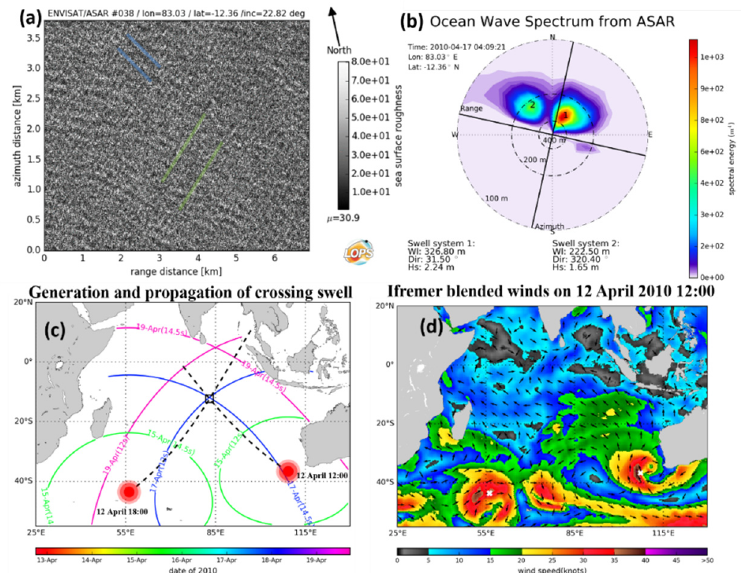
Figure 2. Example of crossing swell in Region A from refocused ASAR observation. ( a ) Roughness of ASAR imagette and ( b ) its corresponding Level-2 swell spectrum (17 April 2008). ( c ) Map illustrating the generation and propagation of this event, with dashed and colored lines indicating swell propagating routes, and the predicted arrival times from the swell origins, respectively. ( d ) Ifremer blended winds (12 April 2008 12:00). Red disks and white crosses indicate origins of crossing swell systems inferred from “fireworks” analysis in ( c , d